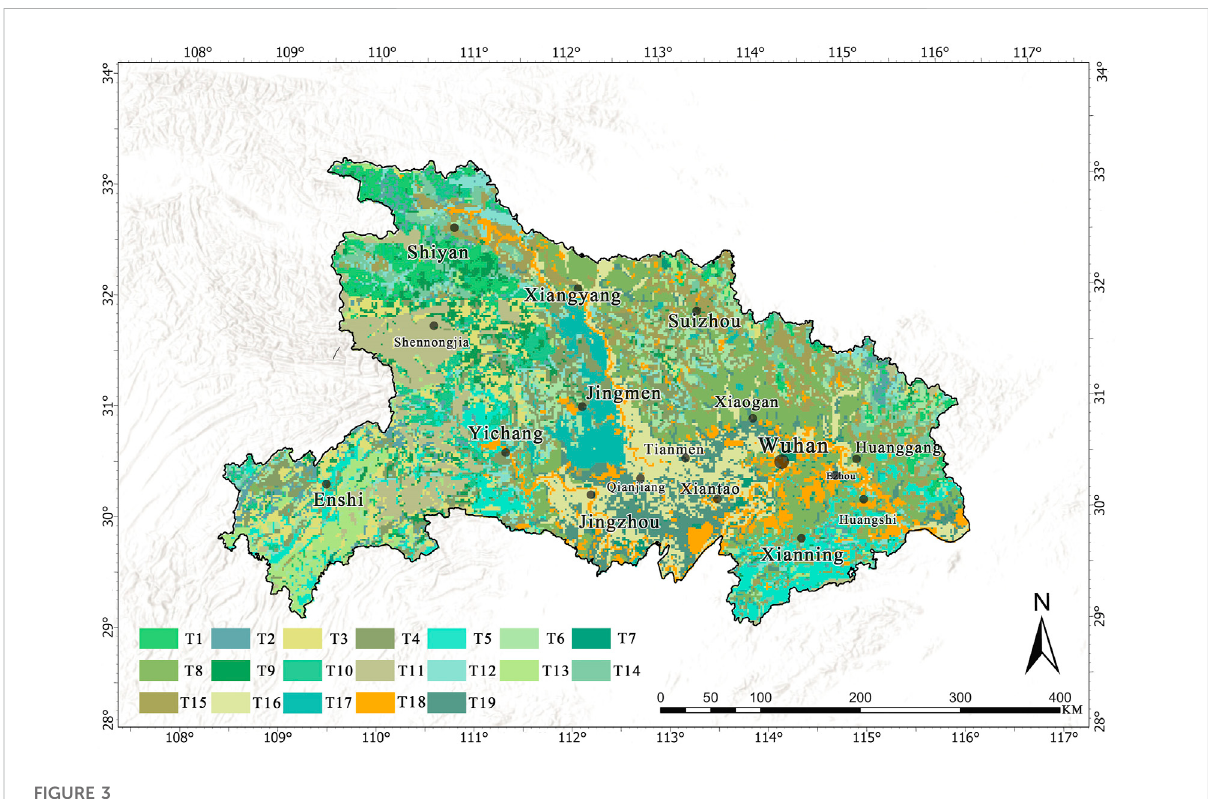
FIGURE 3 Landscape character types in Hubei Province.